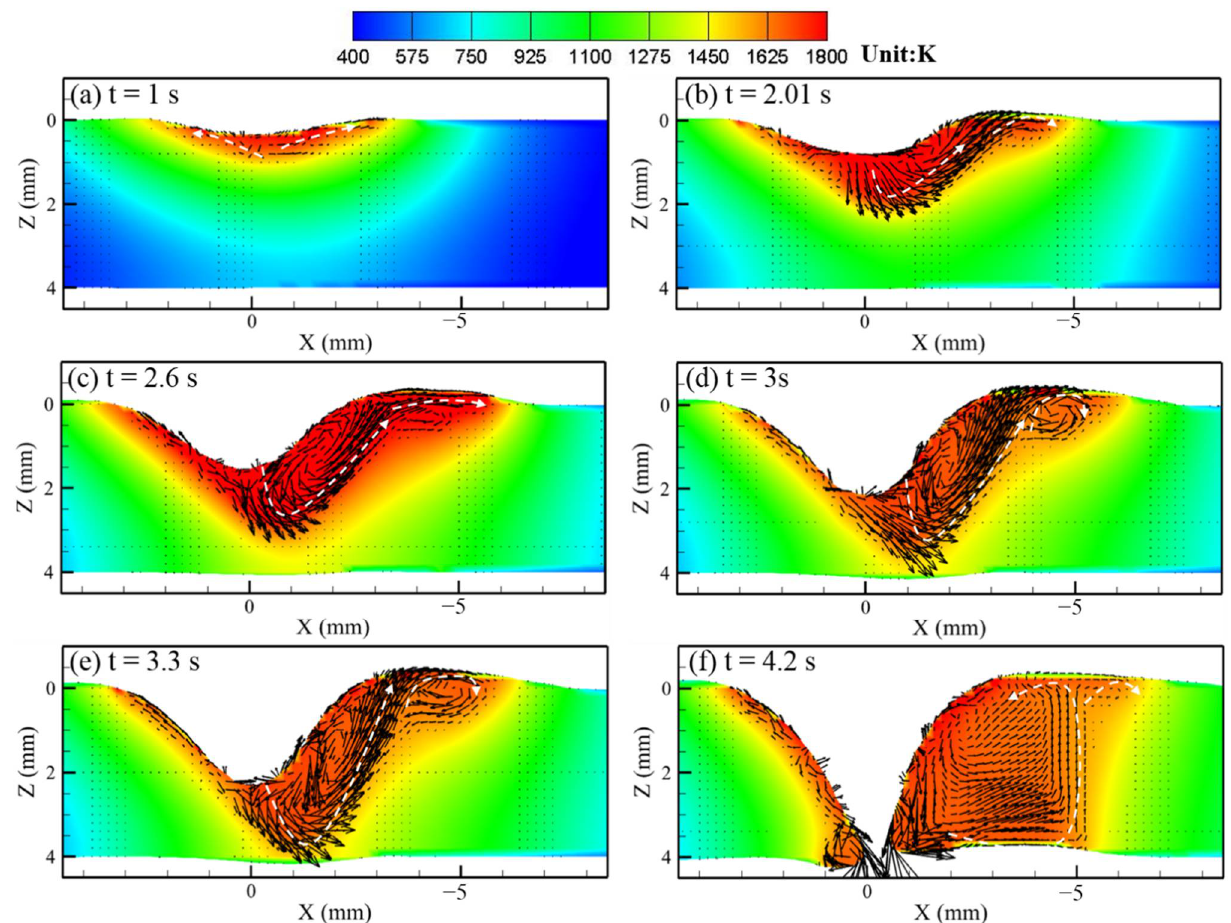
Figure 10. The calculated temperature field, fluid flow, and keyholing time in the U-PAW case.